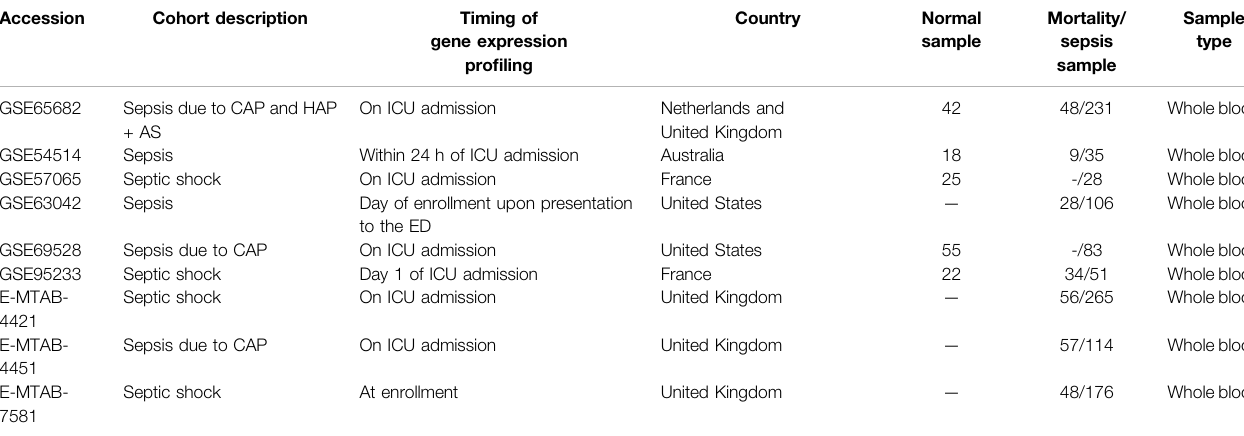
TABLE 1 | Dataset included in the